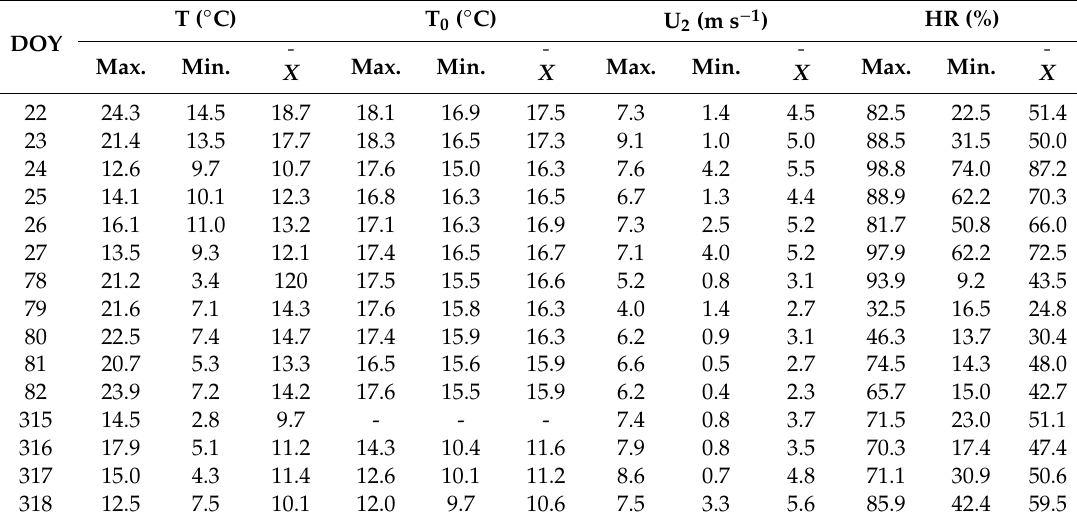
Figure 2. Measured environmental variables. U 2 is wind speed at 2 m above water surface ( a ), VPD is the vapor pressure deficit ( c ), RH is the relative humidity ( e ), T a is the air temperature ( b ), T 0 is water surface temperature ( d ) and, ∆ T is the di ff erence between water lake temperature and air temperature ( f ). Table 3. Daily maximum (Max), minimum (Min) and mean ( X ) values of the environmental variables measured.